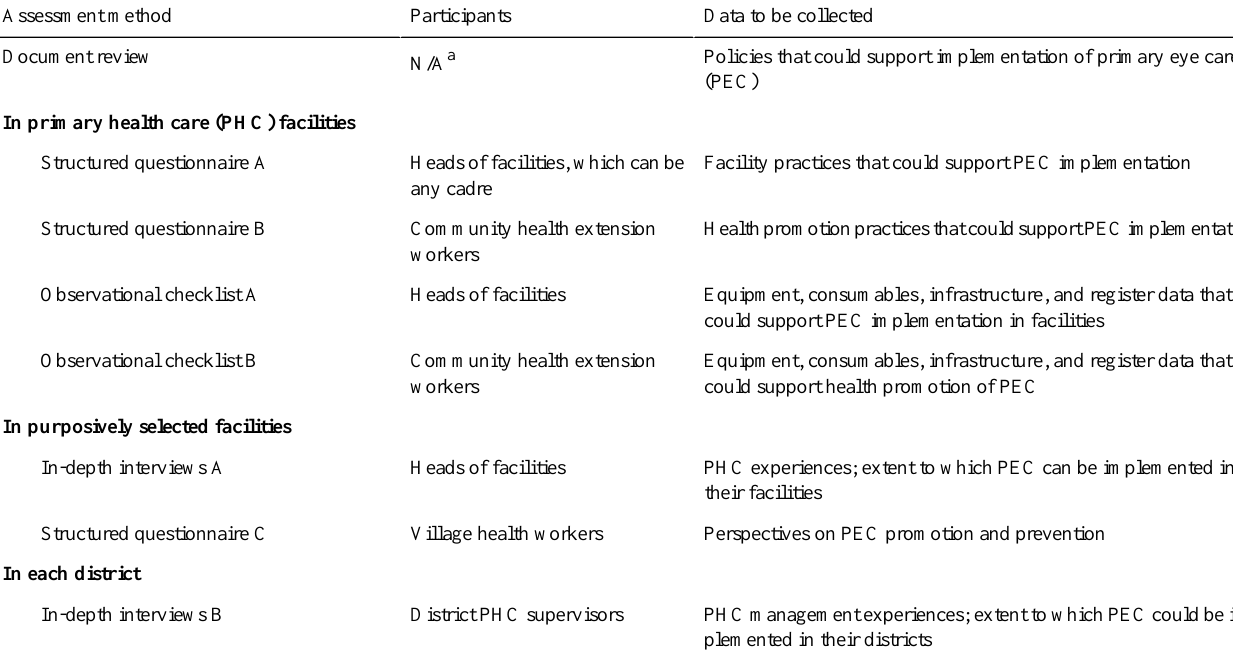
Data to be collectedParticipantsAssessment method